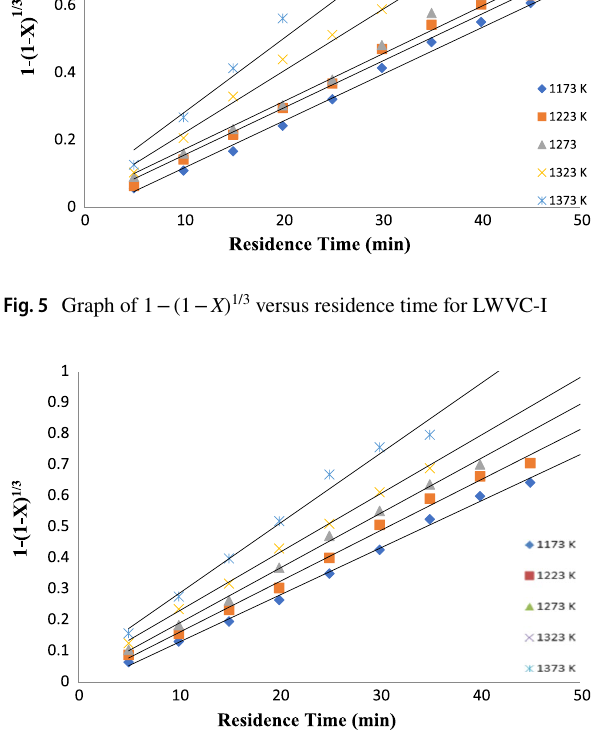
Fig. 6 Graph of 1 − (1 − X ) 1/3 versus residence time LWVC-II Table 5 Reaction rate constant k and k c at different temperatures Temp.